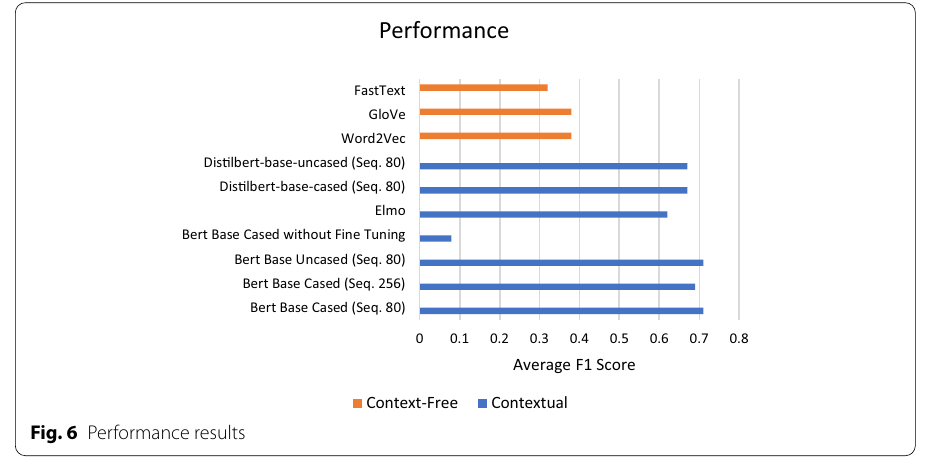
Language Model Class